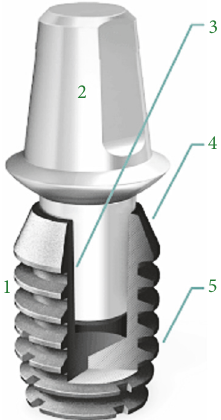
Figure 1: Schematic drawing of the Bicon dental implant system and its macrogeometric features. 1 represents the short root-plateau form implant body; 2 represents the abutment; 3 represents the 1.5 ∘ internal connection (locking-taper); 4 indicates the convergent crest module (sloping shoulder); and 5 represents the implant plateaus